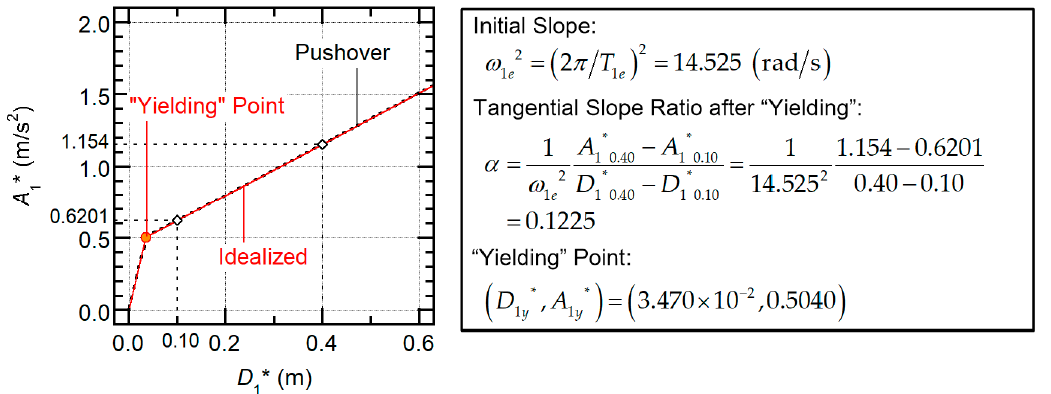
Figure 10. Bi-linear idealization of A 1* - D 1* for the equivalent SDOF model representing the first modal response.